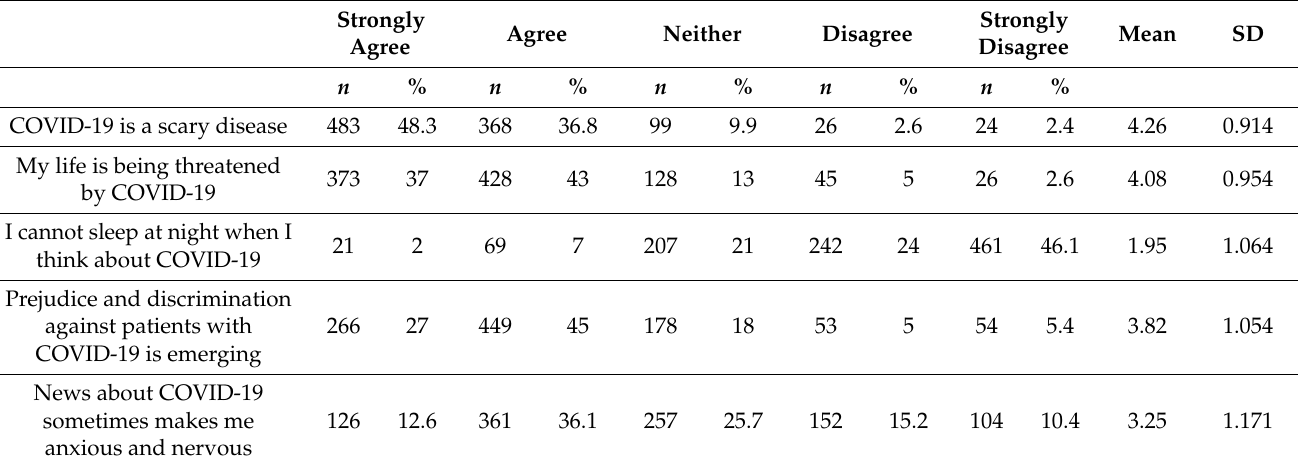
Table 3. Educators’ responses regarding fear of